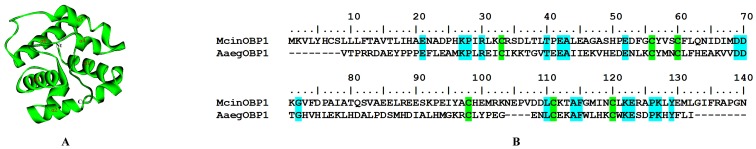
3D structure model of the M. cingulum odorant binding protein 1.(A) Predicted 3D model of McinOBP1 was built on the reference of structure of OBP1 from the Mosquito Aedes aegypti. Six α-helixes, N-terminal (Nt) and C-terminal (Ct) are marked. (B) Sequence alignment of McinOBP1 and AaegOBP1. In the alignment of the two proteins, conserved cysteines are highlighted in green and identical residues are highlighted in light blue.